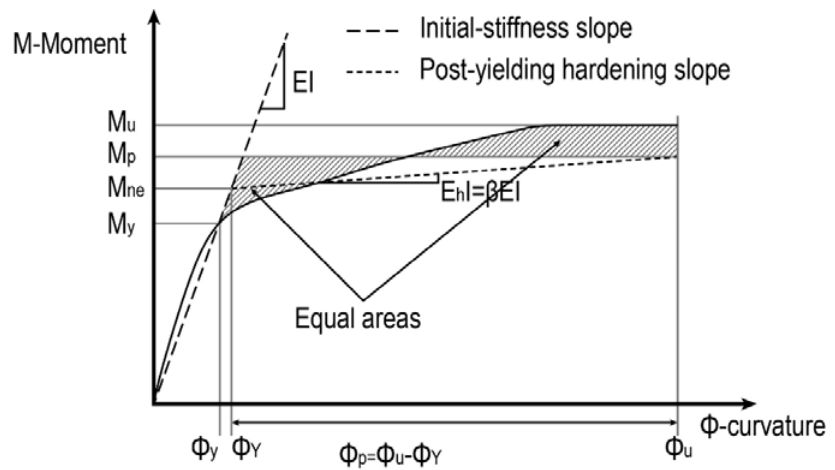
Figure 7. Moment-curvature relation.